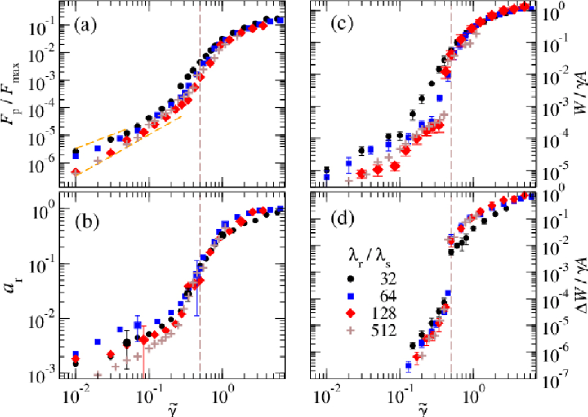
Fig. 4 Same quantities as in Fig. 2. This time, different ratios /  r λ λ are considered and results averaged geometrically over r sf five independent configurations. Moreover, only zero-load relative contact areas are shown. In addition, the work of separation and its hysteresis are represented in two separate panels, i.e., in (c) and (d), respectively. Dashed lines are drawn to guide the eye. Circles, squares, diamonds, and plus symbols represent the data sets for 32, 64,128,  r and 512, respectively. f